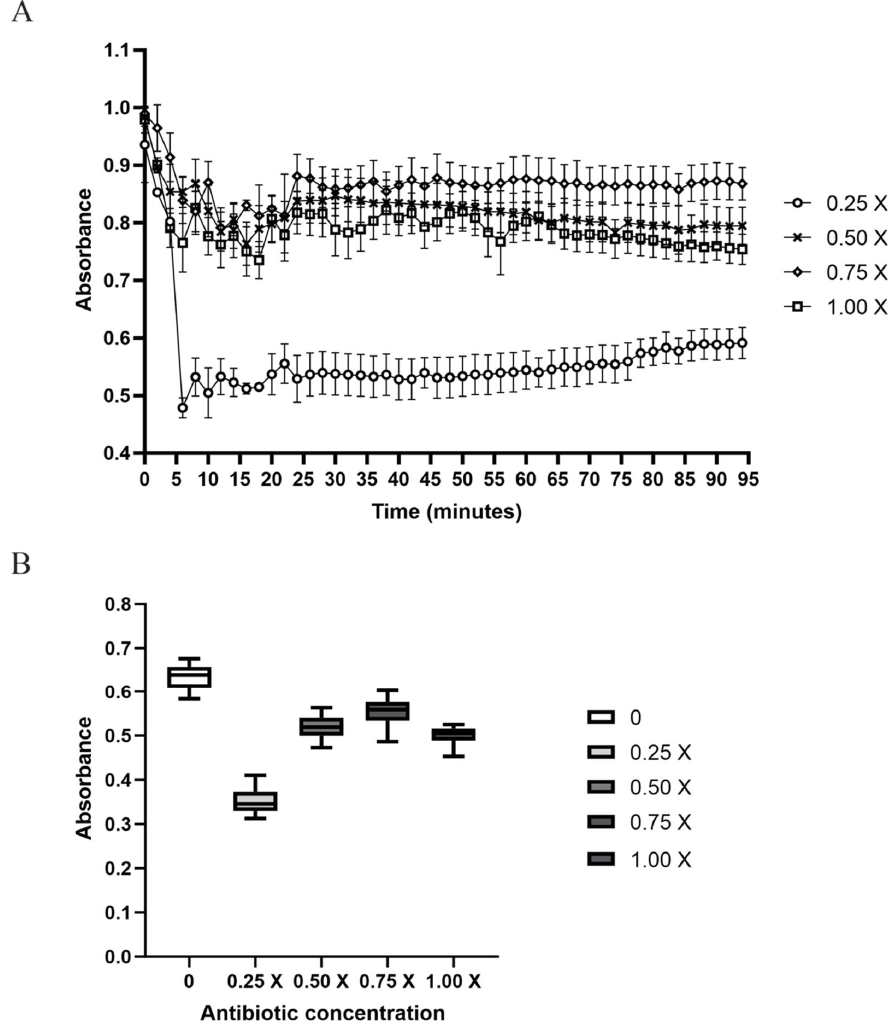
Figure 3. Effect of the supernatants from C29 strain on the clumping of C29 and 1390R. ( A ) Spectrophotometric analysis of clumping in the presence of pheromone medium produced with different concentrations of ampicillin (0.25 × , 0.5 × , 0.75 × , and 1 × MIC) ( p < 0.0001). ( B ) Clumping in the presence of different concentrations of antibiotic. Clumping activity was highest at an antibiotic concentration of 0.25 × MIC ( p < 0.0001).